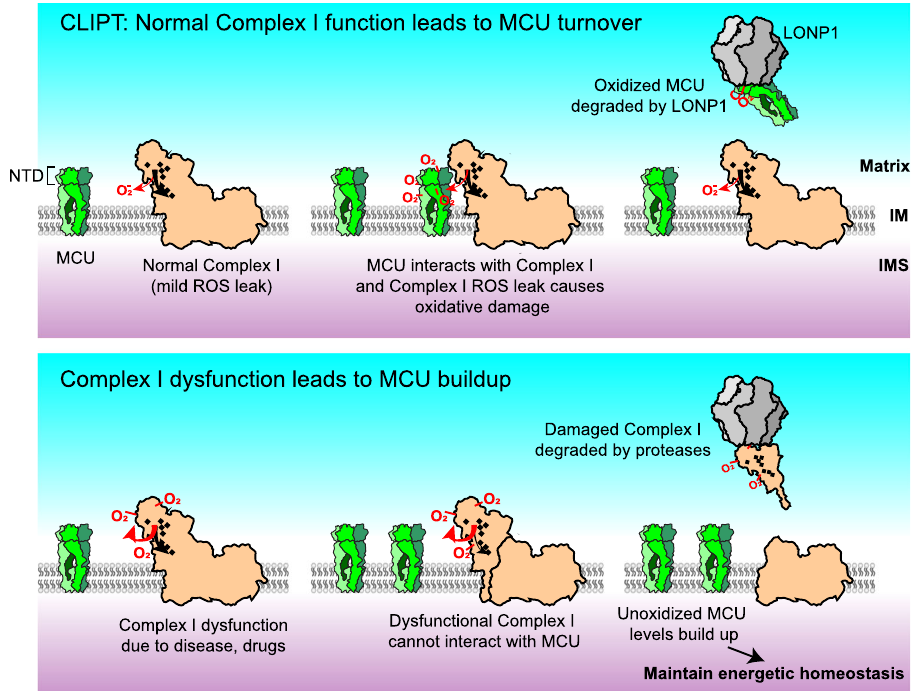
Fig. 7 Current hypothetical model for Complex I-induced protein turnover of MCU. Top, under physiological conditions, MCU interacts with Complex I and is oxidized by the mild ROS leak produced by Complex I. Such oxidized MCU becomes damaged and degraded by LONP1 or other quality-control proteases, leaving Complex I available to interact with additional channels. We term this process Complex I-induced protein turnover (CLIPT). Bottom, when Complex I becomes impaired or misassembled, it produces excessive ROS and self-inactivates. Such dysfunctional Complex I can no longer interact with MCU, nor damage it with basal ROS leak, and is cleared by housekeeping proteases CLPP and LONP1. Thus, functional MCU levels build up, and additional Ca 2 + in fl ux through these channels maintains energetic